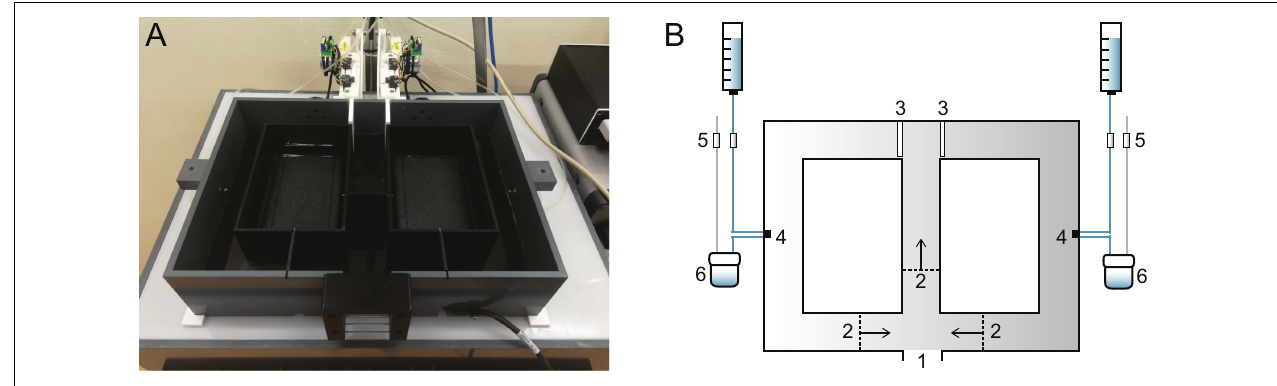
FIGURE 1 | Home cage-based figure-8-maze (F8M) setup. (A) Photograph of the F8M. The maze is made of infrared-transmitting perspex (top lid not shown in photograph) and placed on top of an infrared light box. (B) Schematic drawing of the F8M. The F8M can be connected to the mouse’s home cage so that the mouse can enter the maze voluntarily (1). Once entered, three unidirectional swing doors (2) limit movement of the mouse to one direction as indicated by the arrows. The two motorized doors (3; shown in closed position) are under computer control. When the mouse makes a correct response, a sucrose water reward is delivered to either of two reward orifices (4) in precise preset quantities. Four computer-controlled valves (5) control the delivery of the reward, as well as its retraction by a vacuum pump into a container (6) when not